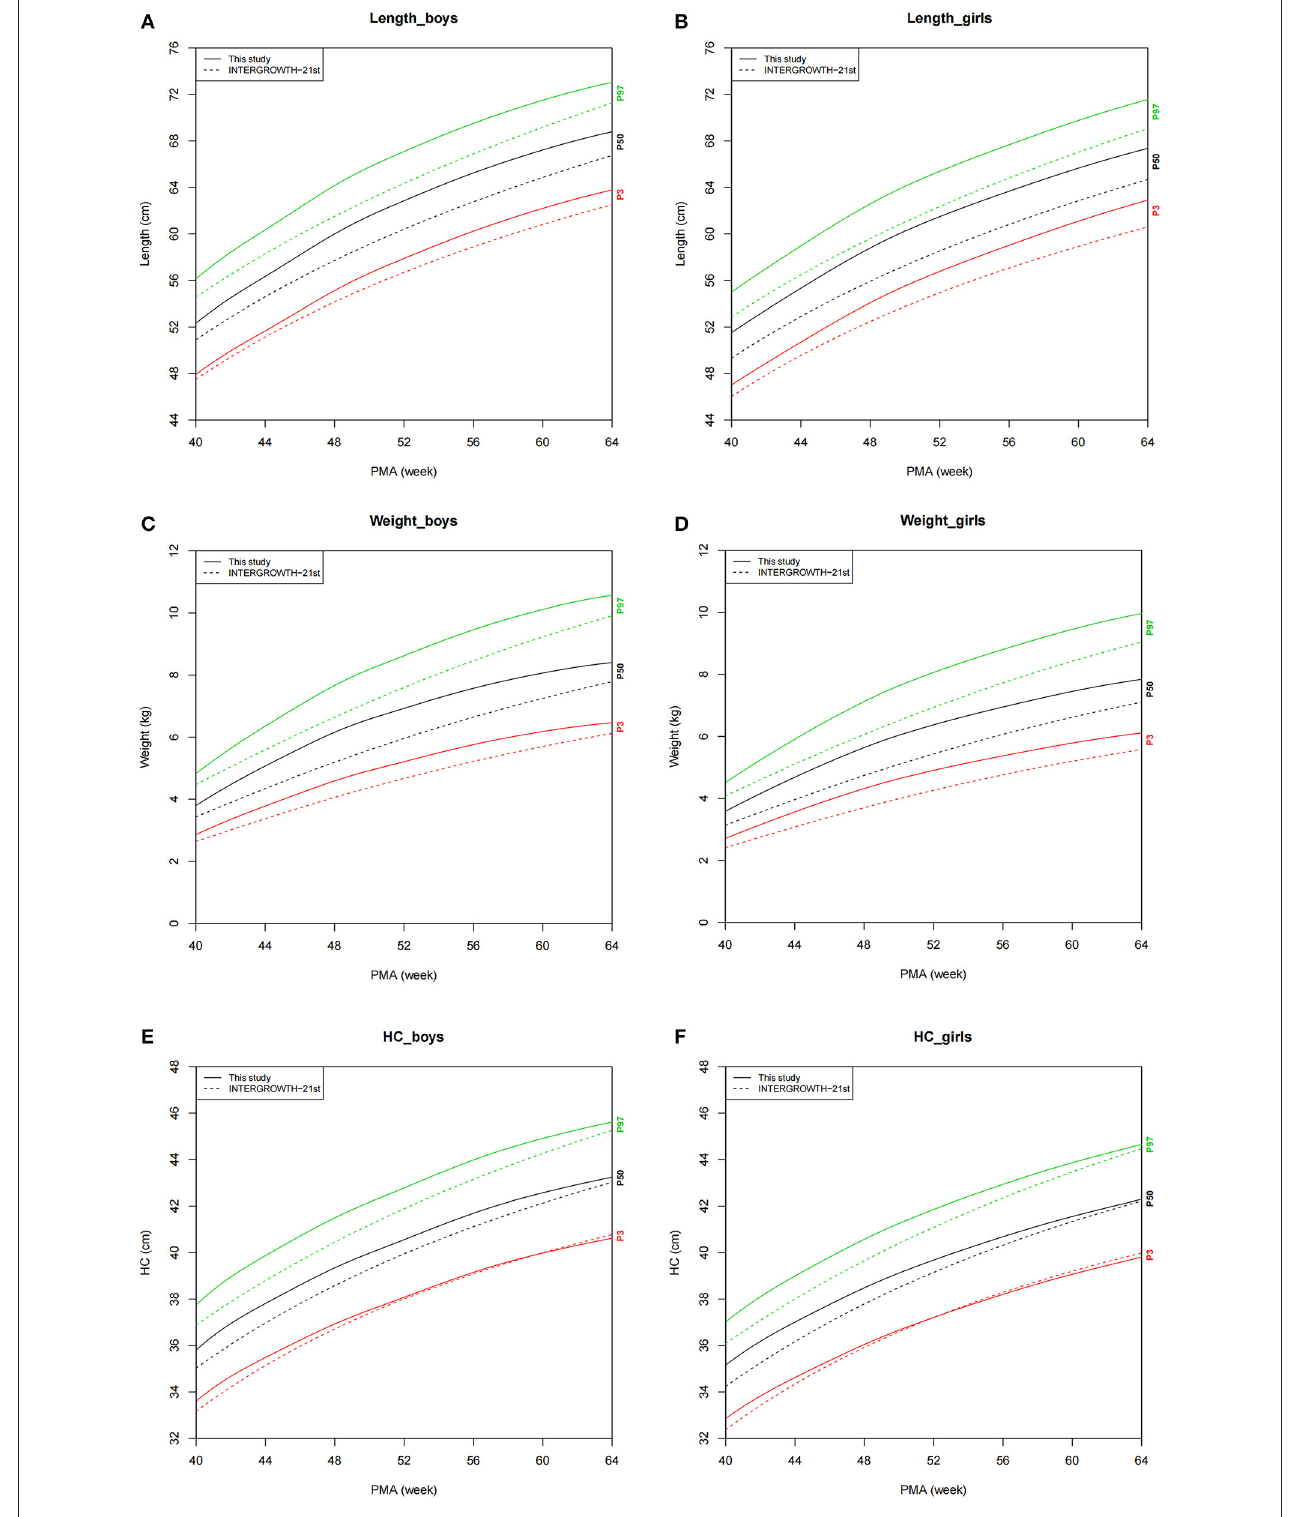
FIGURE 2 | Comparison of growth charts (P3, P50, and P97) between the preterm infants and IPPGS. (A) Length_boys; (B) Length_girls; (C) Weight_boys; (D) Weight_girls; (E) HC_boys; (F) HC_girls. HC, head circumference; IPPGS, INTERGROWTH-21st Preterm Postnatal Growth Standards; PMA, postmenstrual age; P3, P50, and P97, the 3rd, 50th, and 97th